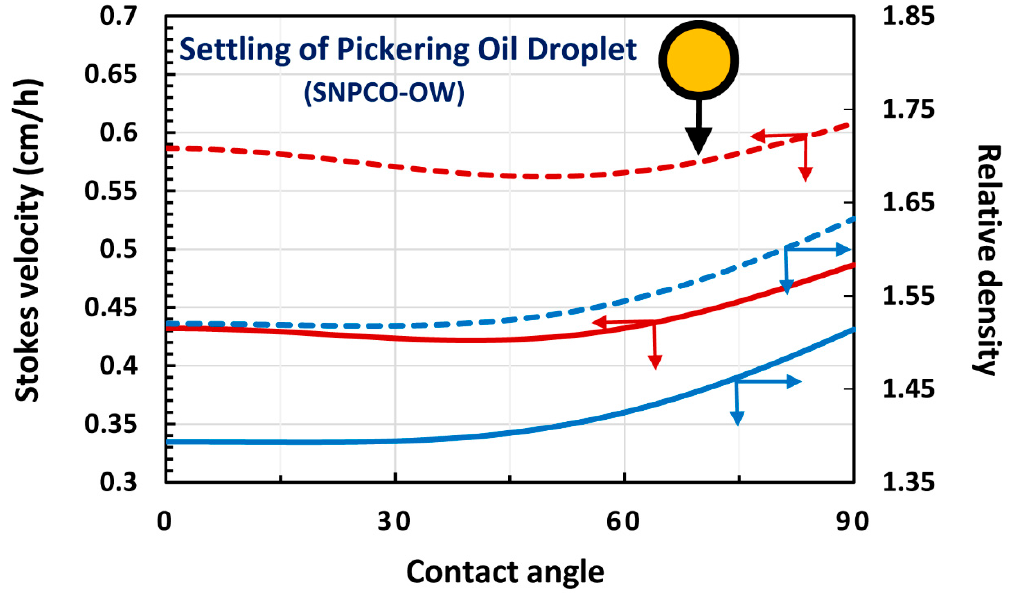
Figure 15. Variations of Stokes settling velocity and relative density of a single Pickering oil droplet with contact angle (SNPCO-OW Pickering emulsion). The solid curves represent square packing and the dashed curves represent hexagonal packing of nanoparticles at the oil-water interface.